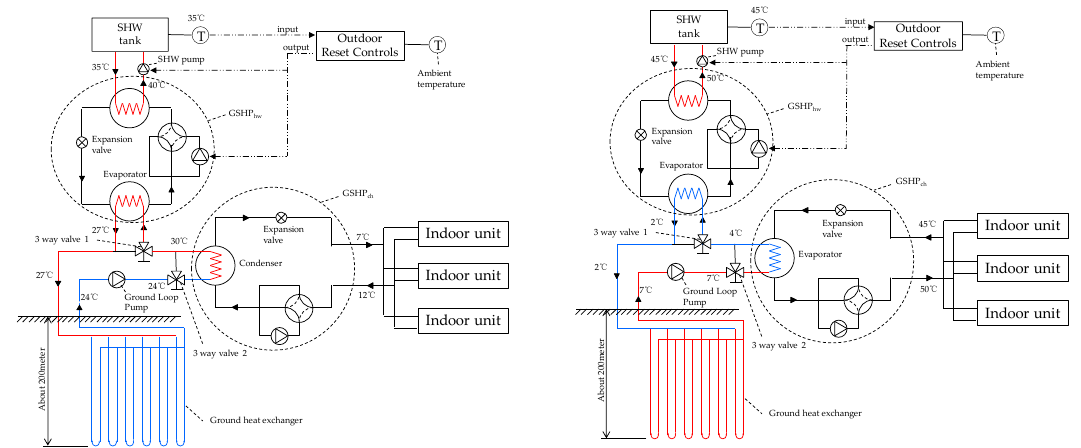
Figure 1. The integrated geothermal heat pump system (modified from [3]) (cooling season on the left and heating season on the right).